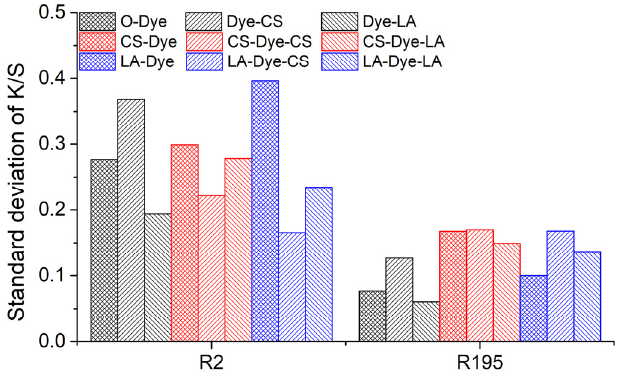
Figure 8. Standard deviations of K/S values of the original and mercerized woven cotton fabrics dyed with R2 and R195 dyes.